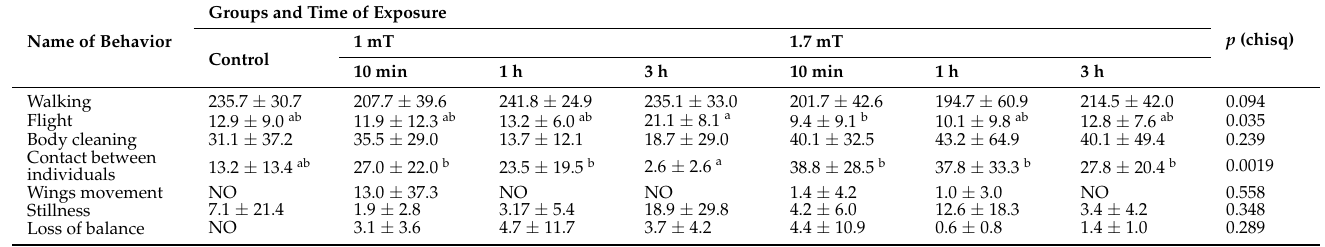
Table 1. Mean total time per bee (s) ± SD, different letters within same behavior—significant differ- ences (Kruskal–Wallis test, p < 0.05), NO—not observed. NO values per group were not included in statistical analysis in any way.